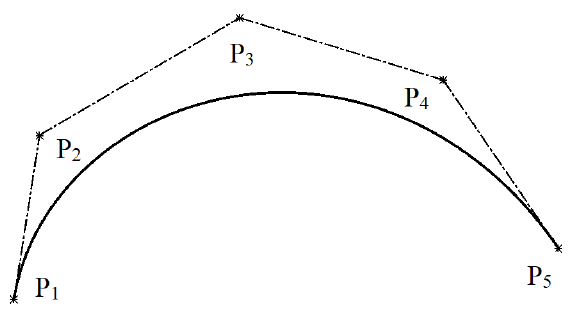
Figure 14. Quartic Bezier curve and its control